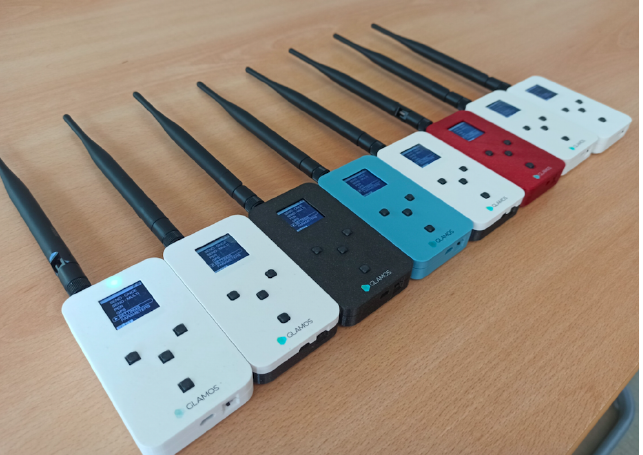
Figure 4. Glamos devices that implement ESP32 microcontroller with WiFi along with RFM95 module with for LoRa